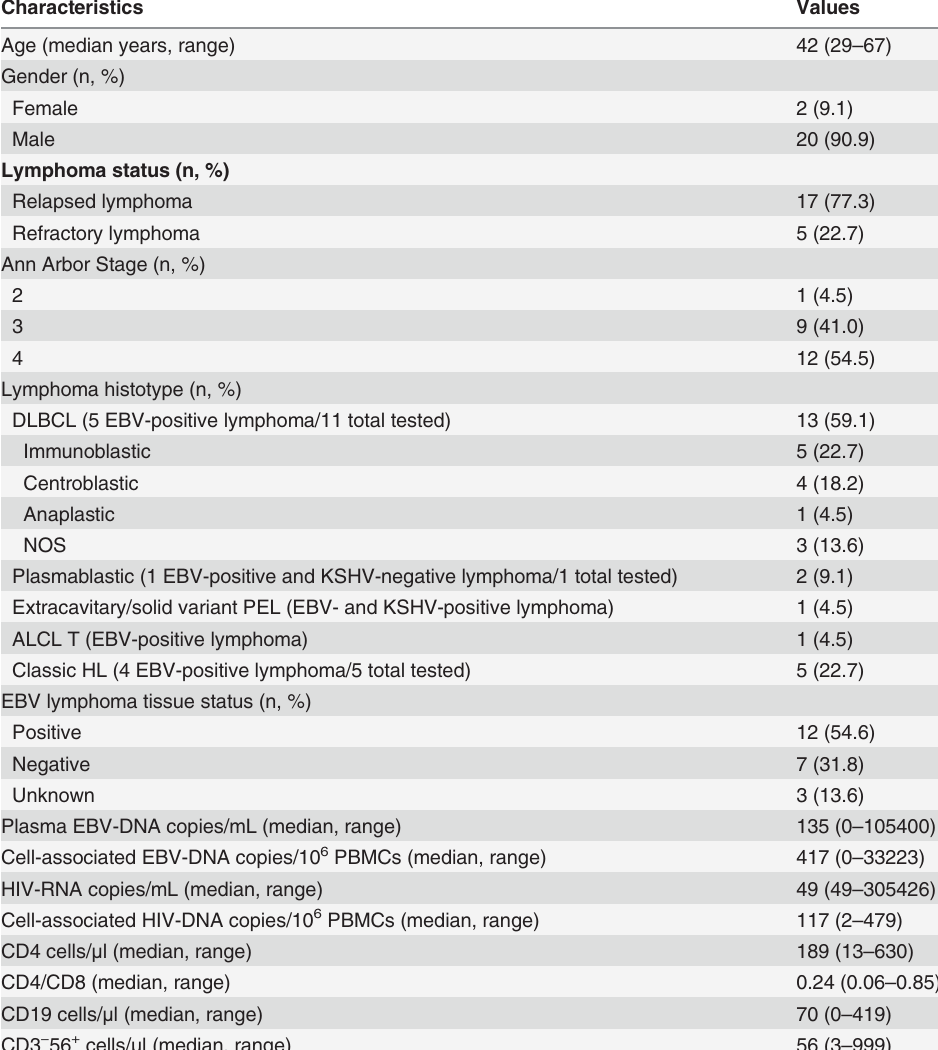
Table 1. Demographic, clinical, histological, virological and immunological characteristics of 22 HIV- 1 lymphoma patients before debulking chemotherapy. Characteristics